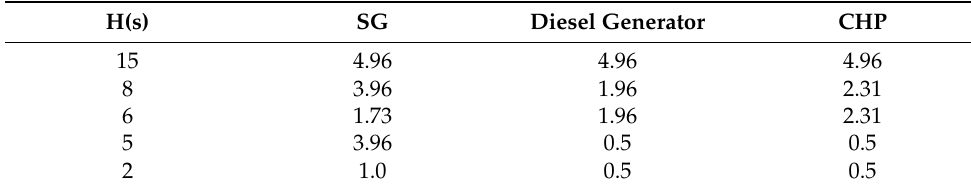
Figure 20. ( a ) Active power injected by CHP in the islanded MG unit during various inertia constants. ( b ) Diesel Unit Power Delivery for different Inertia-100 MW SG Loss. ( c ) Wind farm Unit Power Delivery for different Inertia-100 MW SG Loss. ( d ) Solar Unit Power Delivery for different Inertia-100 MW SG Loss. Table 7. Different Values Implemented for Inertia